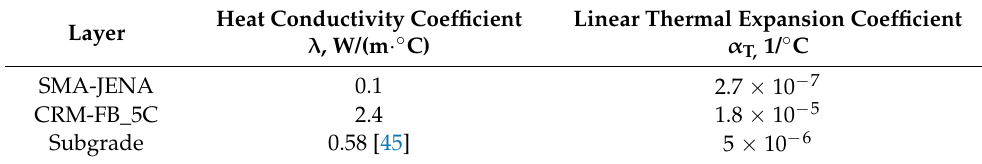
Table 6. Trial section thermal parameters.